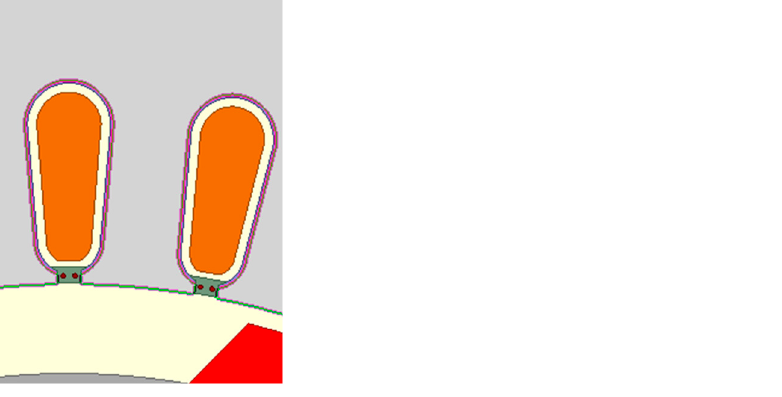
Figure 12. Fragment of the field model with the use of shielding wires inside the stator wedges.